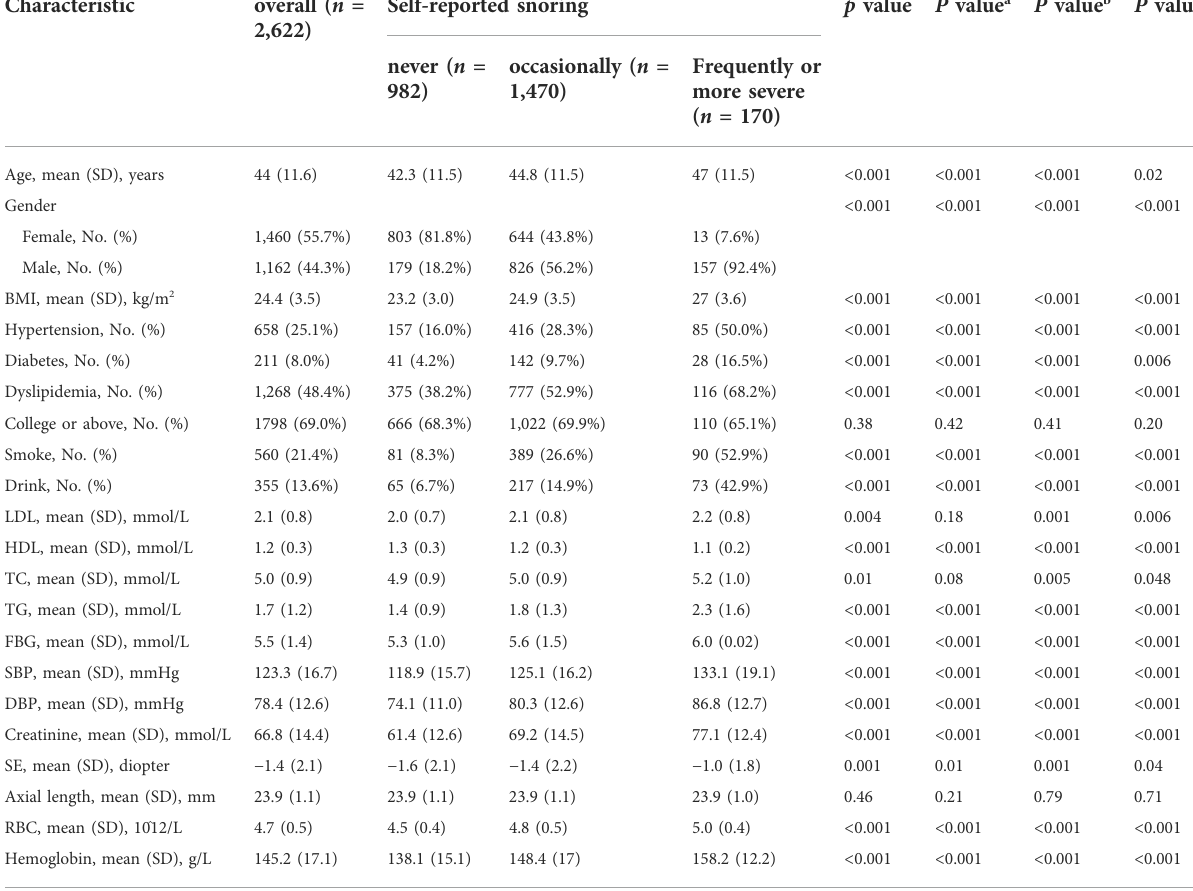
TABLE 1 Baseline characteristics of eligible participants according to frequency of self-reported